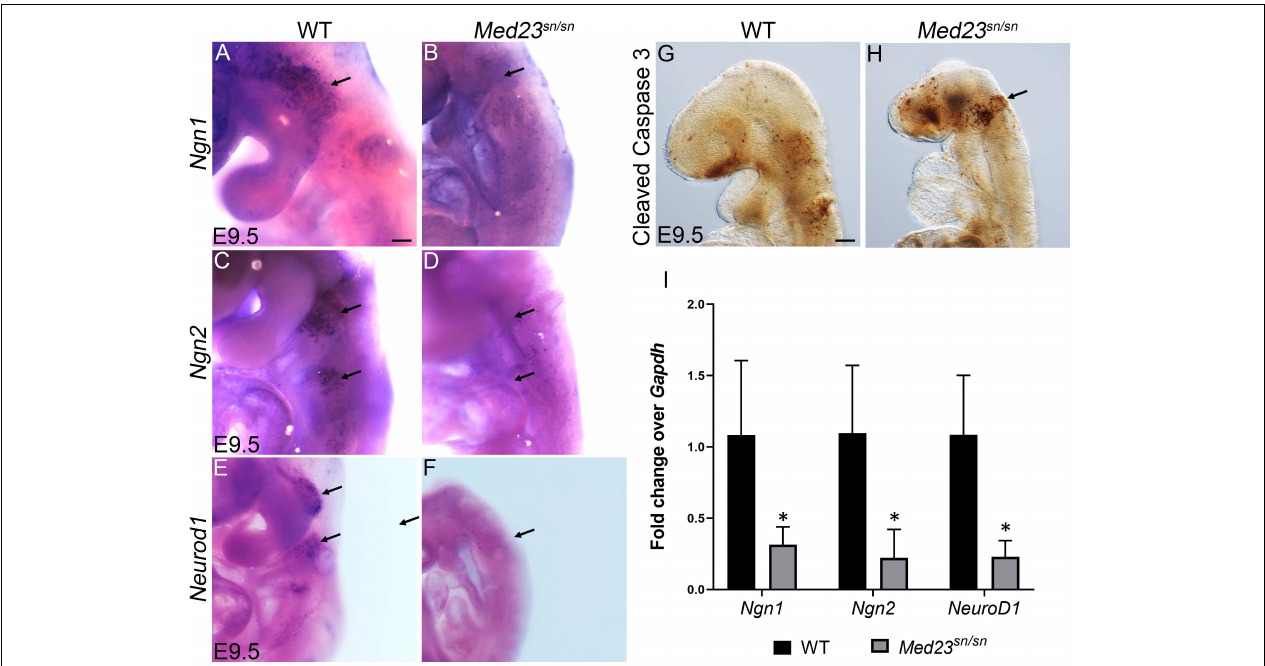
FIGURE 4 | Med23 sn / sn mutants display defects in neuronal differentiation. (A,B) Ngn1 is expressed in trigeminal (arrow) and epibranchial cells in control embryos, however is downregulated or lost in Med23 sn / sn embryos. (C,D) Ngn2 + cells are observed in the epibranchial ganglia of control embryos (arrows, C ). Ngn2 + cell number is drastically reduced in the epibranchial ganglia of Med23 sn / sn embryos (arrows, D ). (E,F) Neurod1 + cells are considerably reduced in the developing trigeminal and epibranchial ganglia of Med23 sn / sn embryos at E9.5 compared to controls. (G,H) A higher number of cleaved Caspase 3 positive cells are observed in the developing trigeminal and frontonasal prominence of E9.5 Med23 sn / sn embryos compared to controls. (I) qPCR analyses of E9.5 wild-type and Med23 sn / sn littermate embryos revealed downregulation of Ngn1 , Ngn2, and NeuroD1 transcripts in the mutants. Statistical analysis was performed using ANOVA and ∗ denotes a p -value < 0.05. Scale bar for (A–F) is 150 um, (G,H) is 300 um. * p <